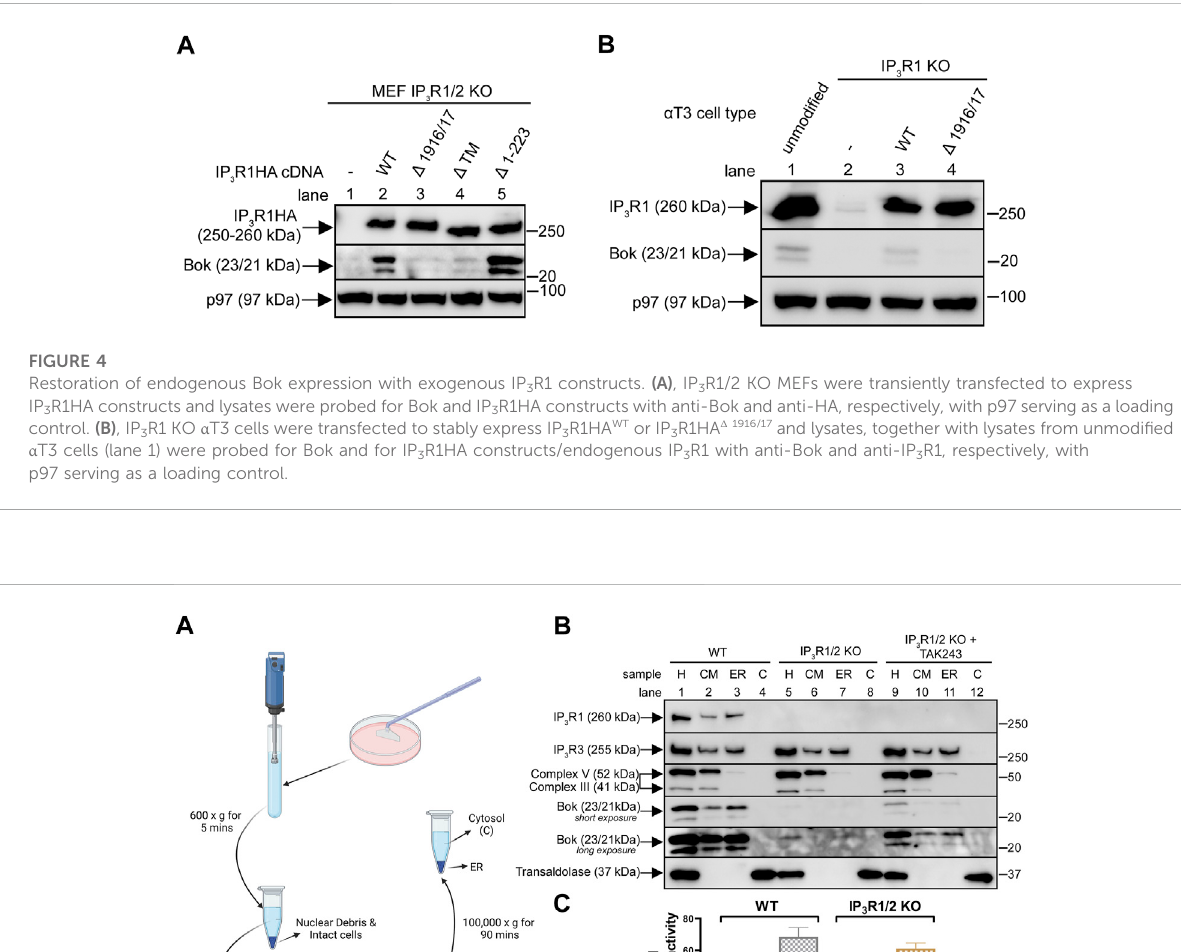
signi fi cantly more apoptosis than 3F-Bok WT , as indicated by caspase-3 and PARP cleavage, as well as cell death (Figure 7A, lanes 1 – 3, blot, histogram and insert). As exogenous Bok and anti-apoptotic Mcl-1 interact (Lucendo et al., 2020; Szczesniak